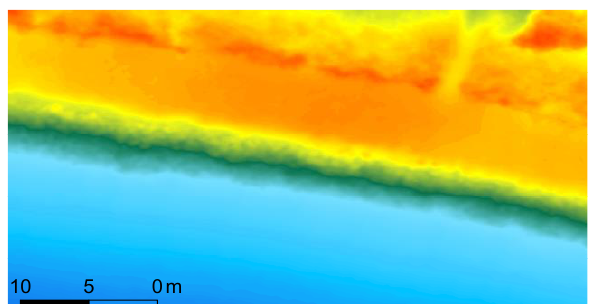
Figure 11: DSM of the Rock dike of La Perroche. The cell size is 9